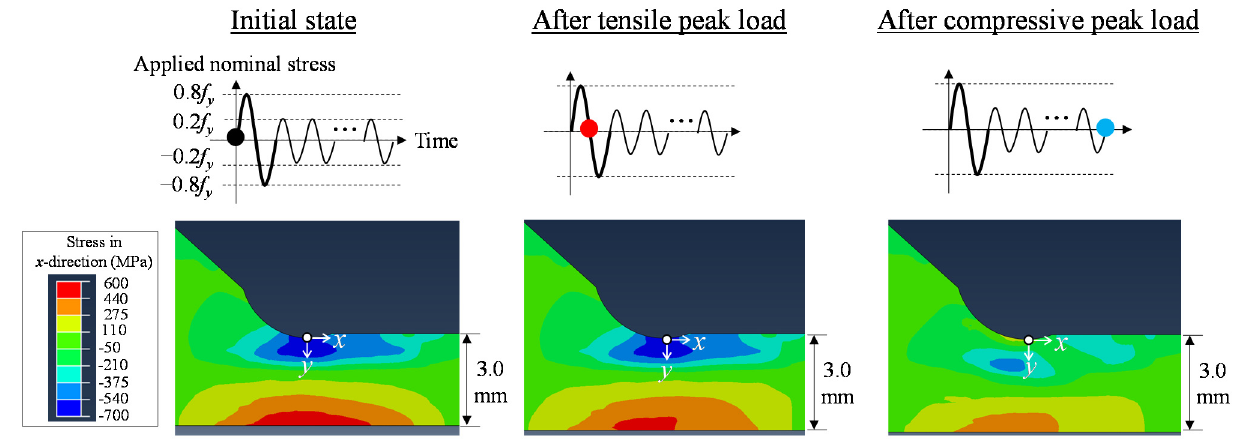
Figure 13. Change of residual stress state due to the applied load cycles in the FE model.